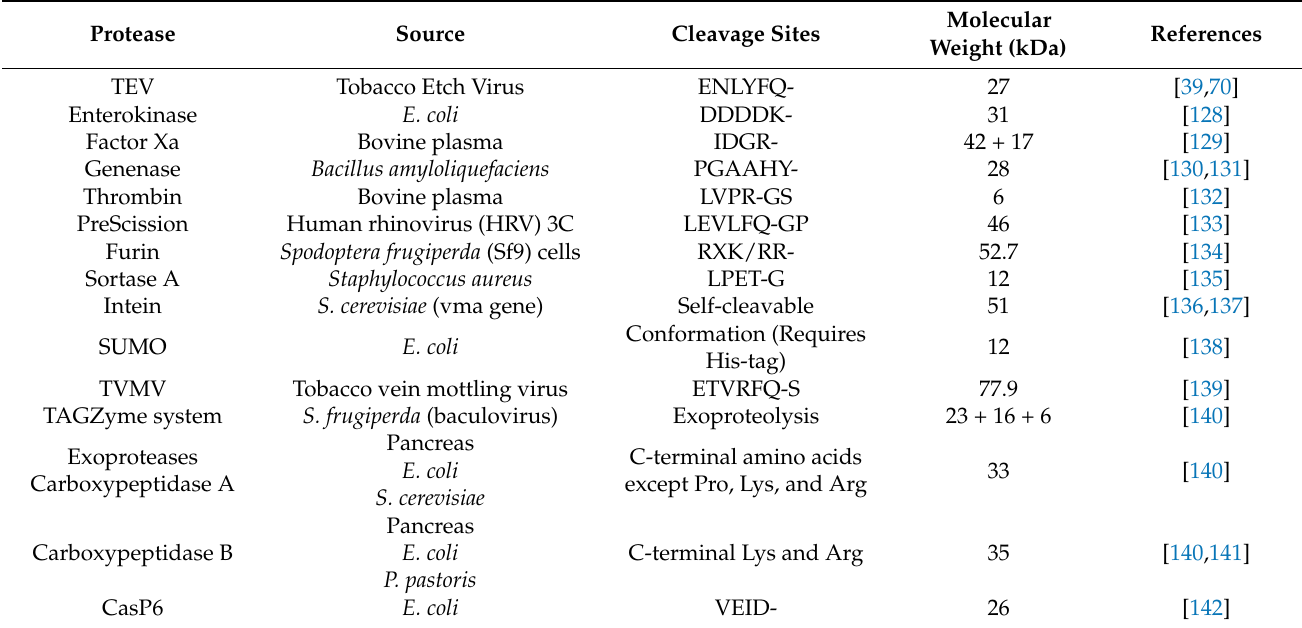
Table 3. Common proteases for tag